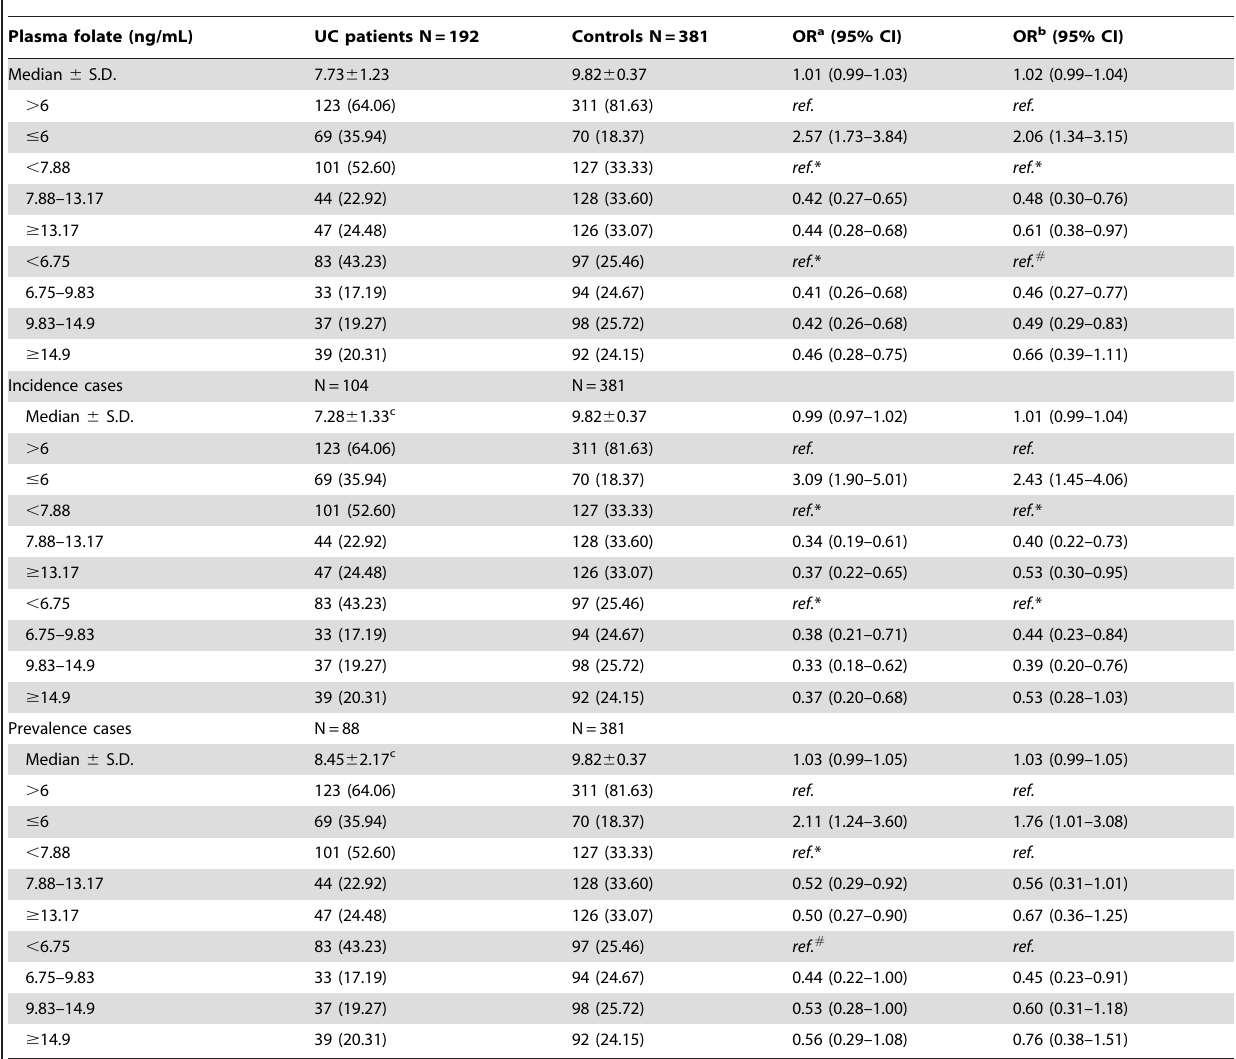
Table 2. Associations between the levels of plasma folate and UC risk by using multivariate logistic regression models.